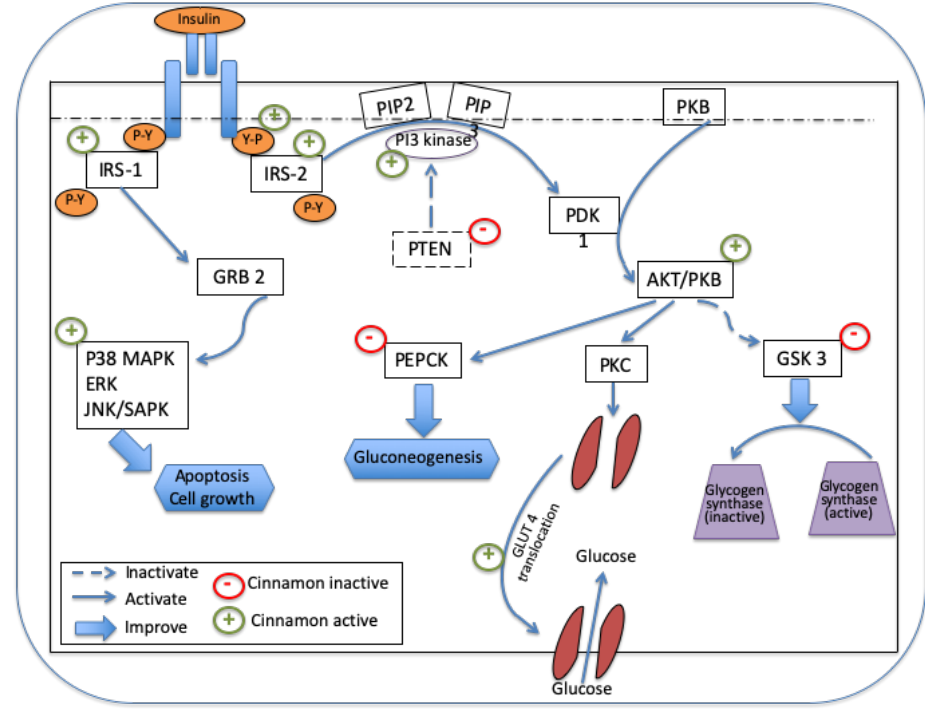
Figure 2. A schematic model illustrating the proposed mechanism(s) of action of cinnamon and its isolated bioactive compounds on glycemic control. Legend: IRS, insulin receptor substrate molecule; PIP2, phosphatidylinositol 4,5-biphosphate; PIP3, phosphatidylinositol 3,4,5-triphosphate; PI3 kinase, phosphatidylinositol 3-kinase; PTEN, phosphatase and tensin homolog; GRB2, growth factor receptor-bond protein 2; p38 MAPK, p38 mitogen-activated protein kinase; ERK, extracellular-signal-regulated kinases; JNK/SAPK, c-Jun N -terminal kinase/stress-activated protein kinase; PEPCK, phosphoenolpyruvate carboxy-kinase; PDK1, 3-Phosphoinositide-dependent kinase 1; PKB/AKT, protein kinase B; PKC, protein kinase C; GSK 3, glycogen synthase kinase 3; GLUT 4, glucose transporter protein.